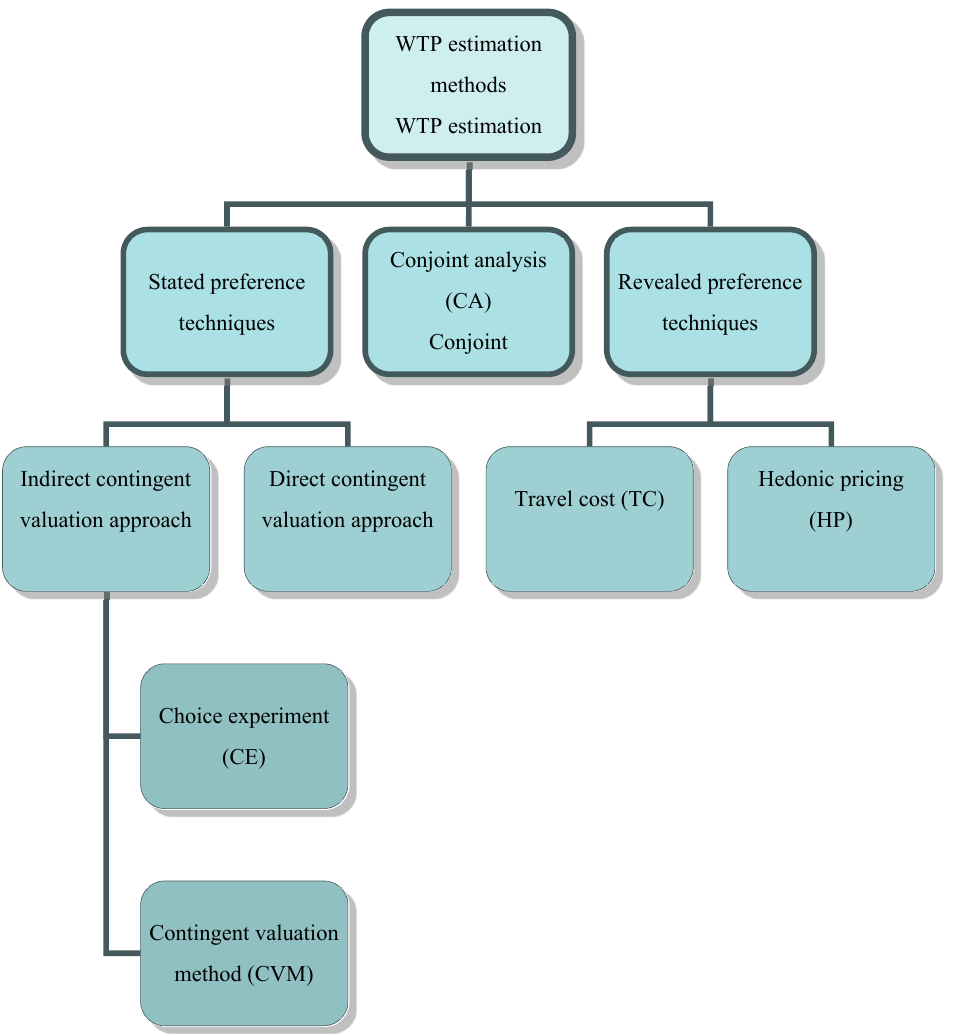
Figure 2. Methods to assess WTP (Willingness to Pay). Source: Created by the authors.